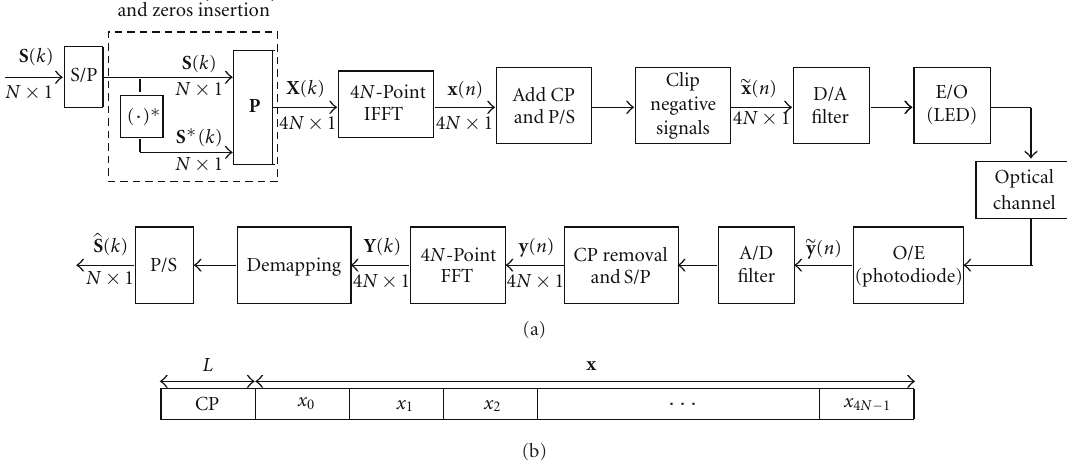
Figure 2: (a) ACO-OFDM transmitter and receiver configuration. (b) ACO-OFDM symbol after cyclic